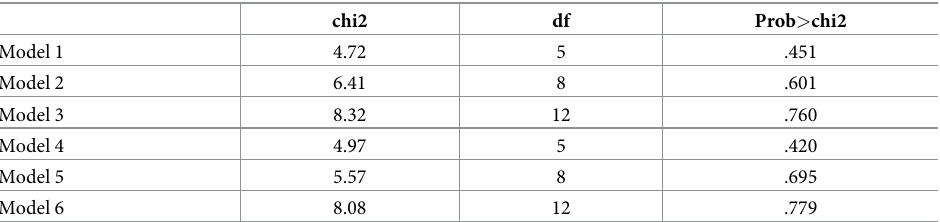
Table 2. Global tests of proportional-hazards